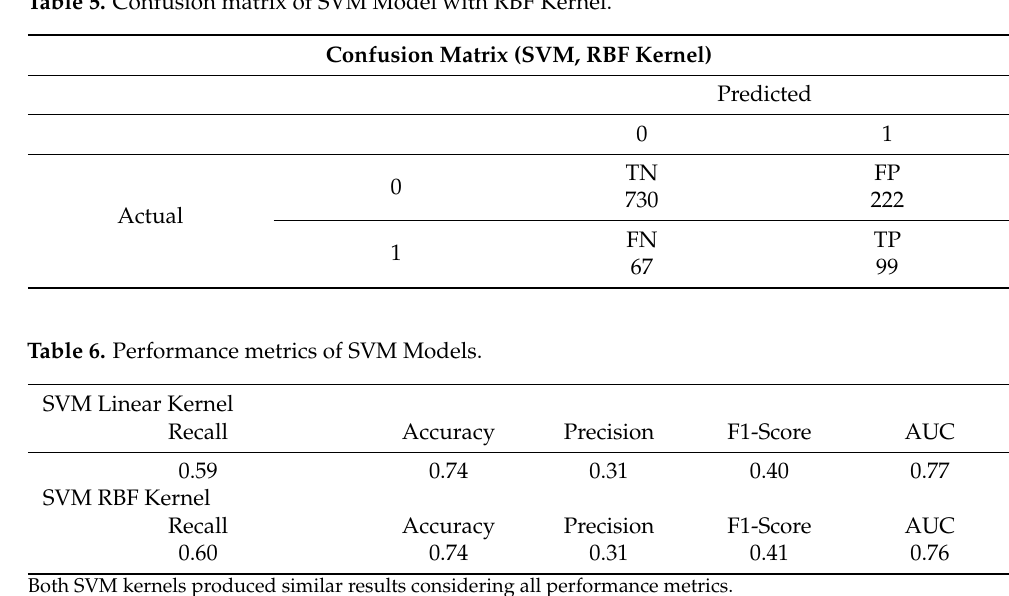
Table 5. Confusion matrix of SVM Model with RBF Kernel.